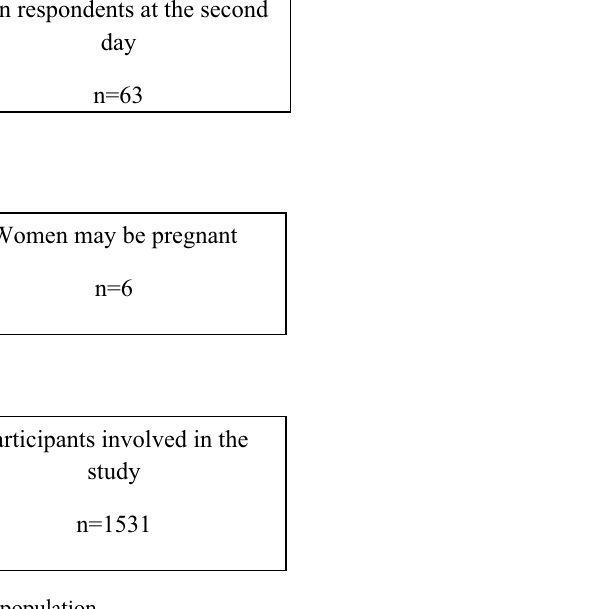
Figure 2. Selection of the study